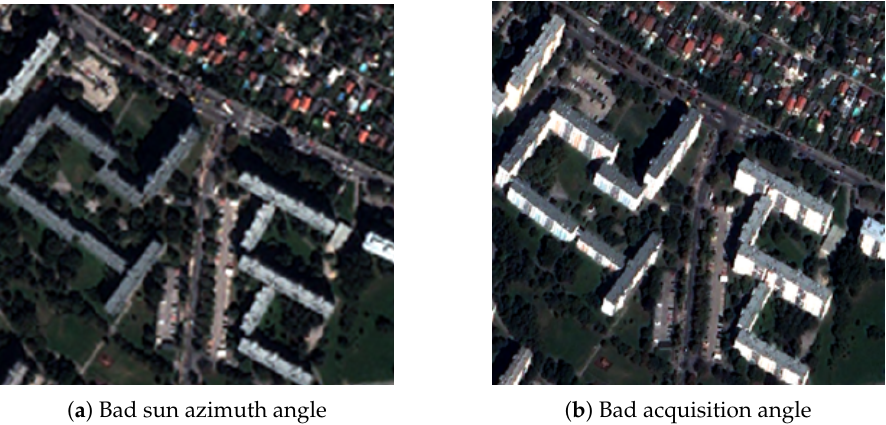
Figure 4. Unwanted effects in satellite imagery for BFP extraction: ( a ) example of VHR data with suboptimal solar azimuth angle; ( b ) cutout of tile with large off-nadir angle leading to a tilted